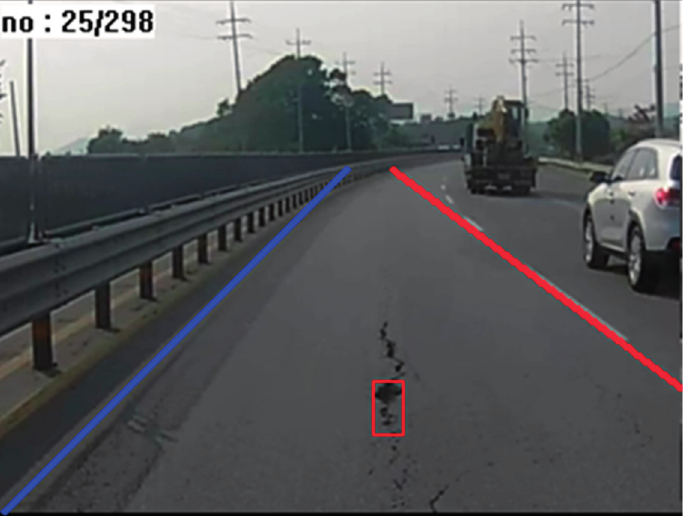
Figure 10. Result of pothole detection.